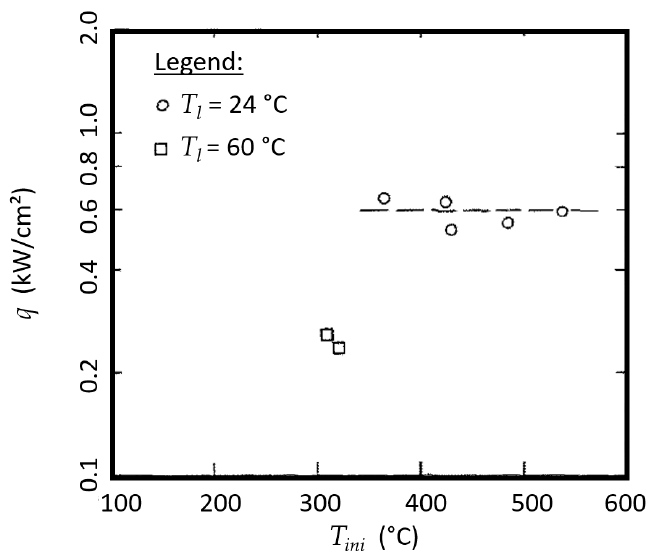
Figure 13. Heat flux at the moment of transplosion ( q , Y-axis) as a function of the initial sphere temperature ( T ini , X-axis) for different coolant temperatures (adapted from Reference [66]).